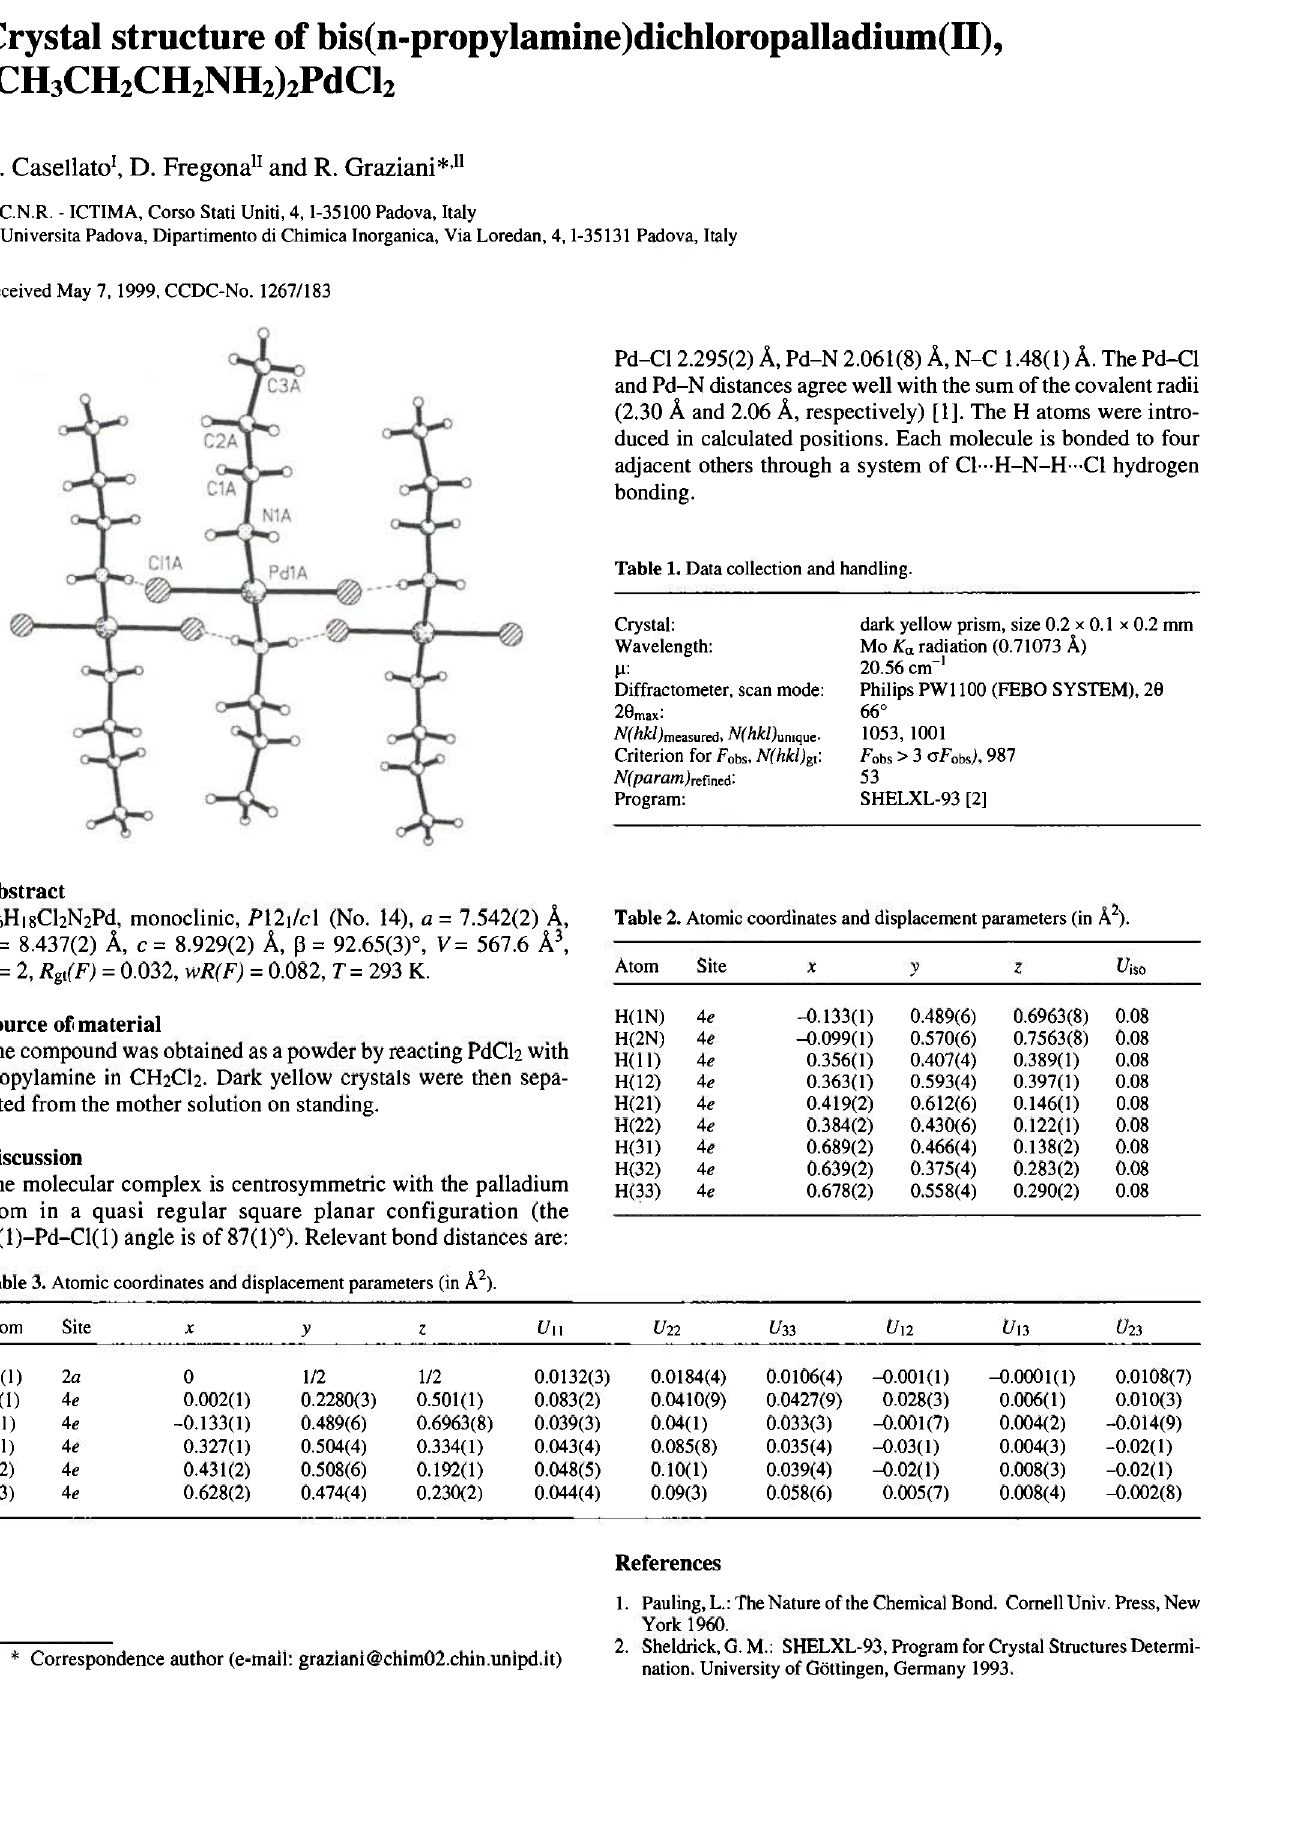
Table 1. Data collection and handling.